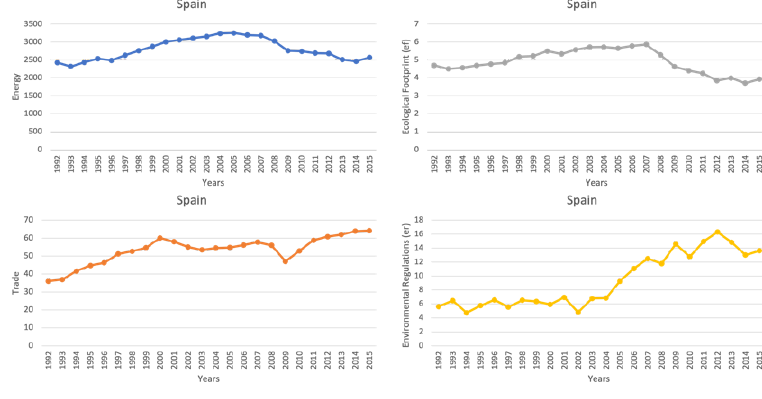
Figure 4. Data visualization for Spain.